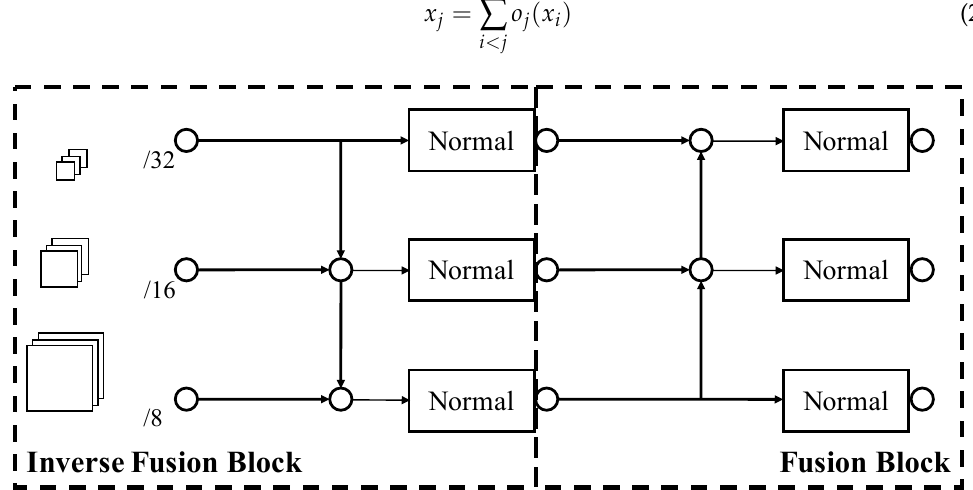
Figure 2. Macro architecture of the supernet for feature pyramid network (FPN). Features in three spatial scales are fed into the FPN module. Each normal cell is a supernet independently searched during the search